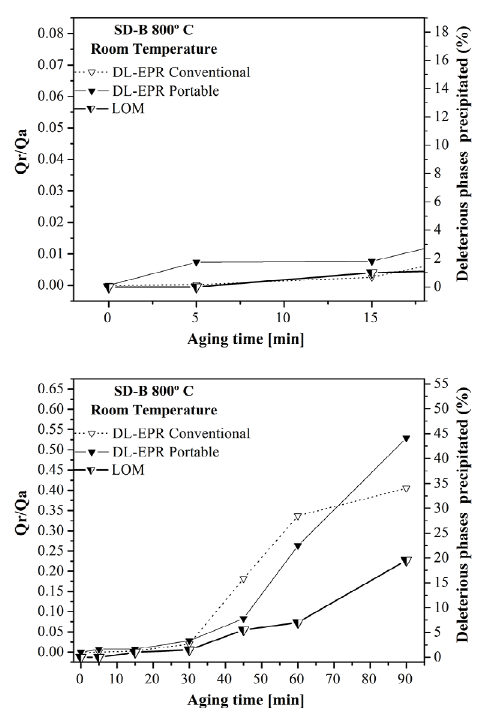
Figure 8. Microstructures obtained after portable DL-EPR test performed at room temperature in SD-A material aged at 850ºC for 15 minutes.